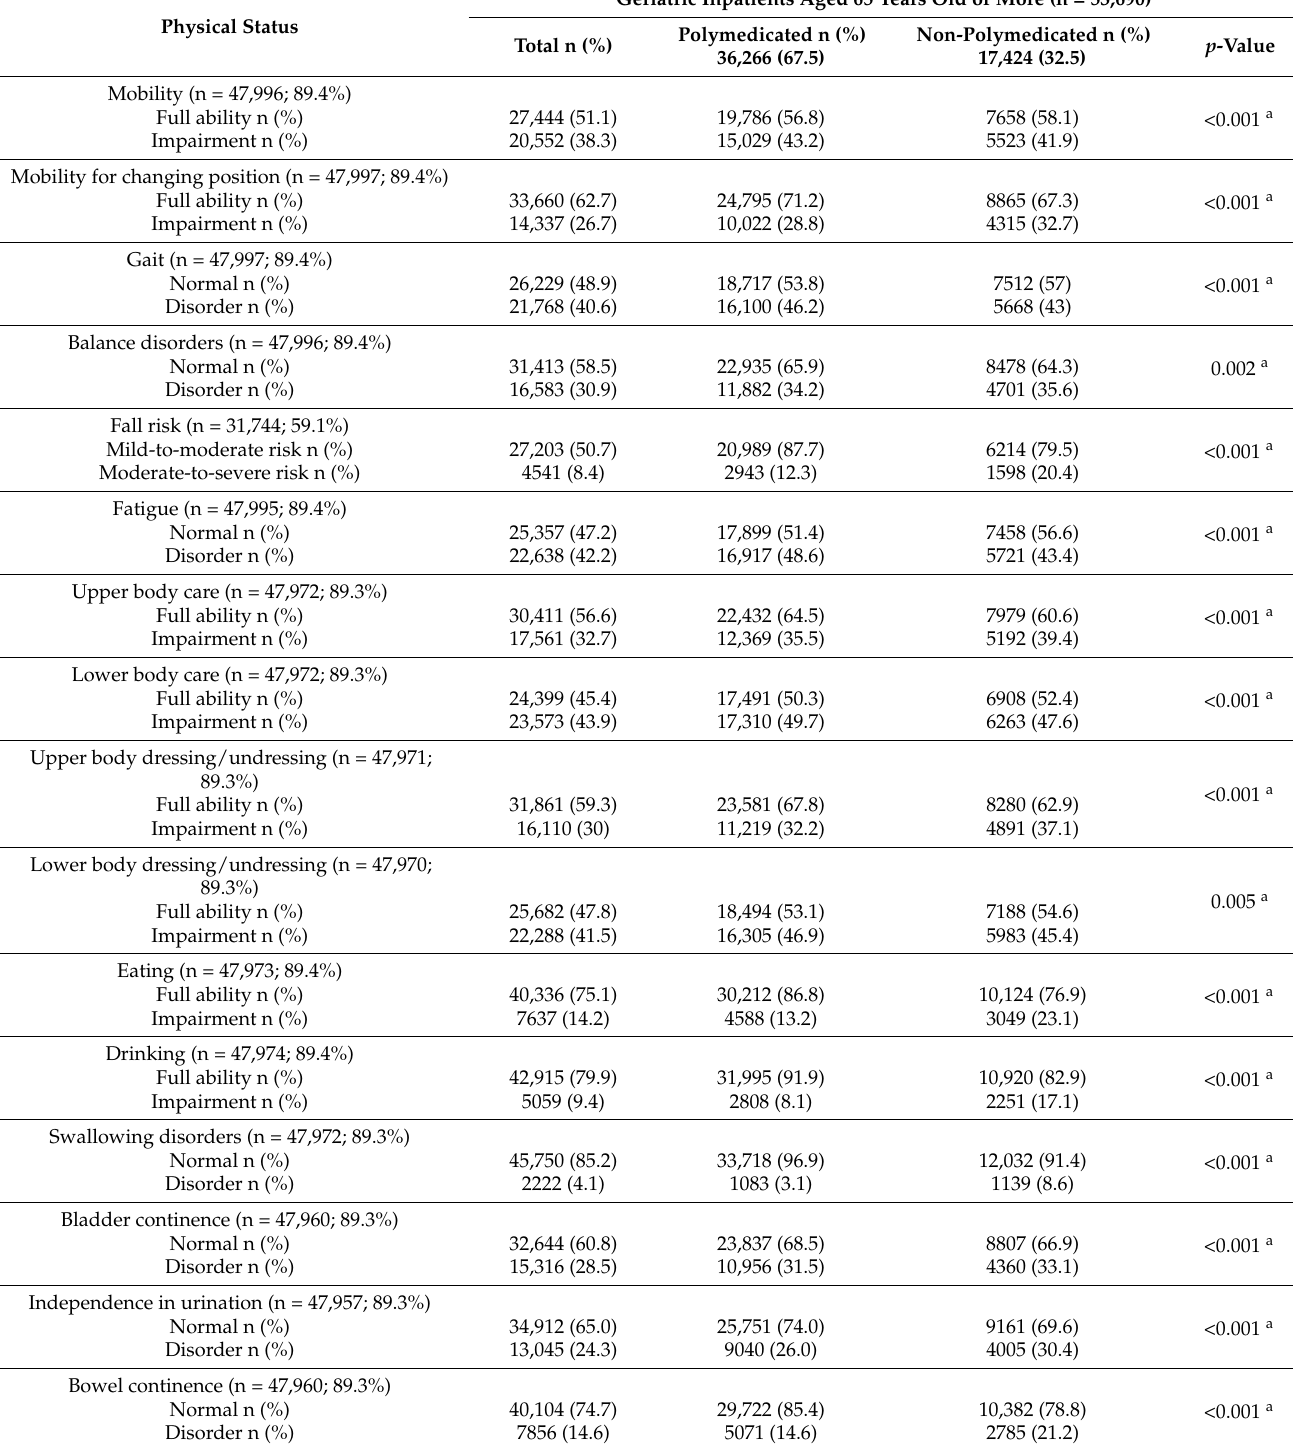
Table 2. Distribution and comparison of the physical status of the polymedicated (n = 36,266) and non-polymedicated (n = 17,424) geriatric inpatients at hospital